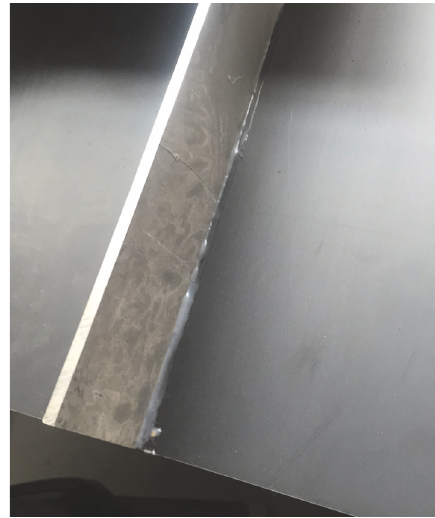
Figure 7: The detailed picture of stiffened orthotropic plate.